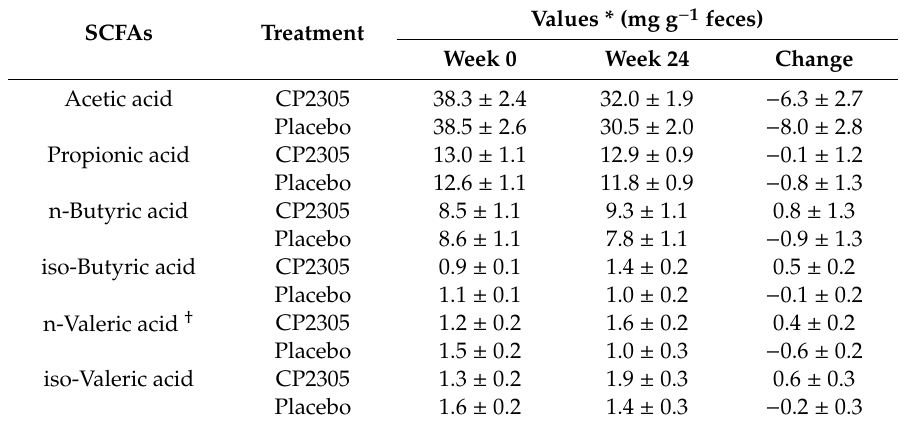
Table 5. Concentration of short-chain fatty acids (SCFAs) in